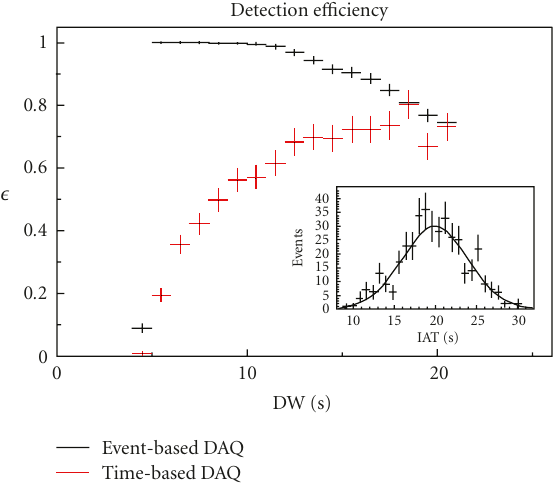
Figure 27: Average response time distribution for Event-based and Time-based DAQ models as a function of the DW width.